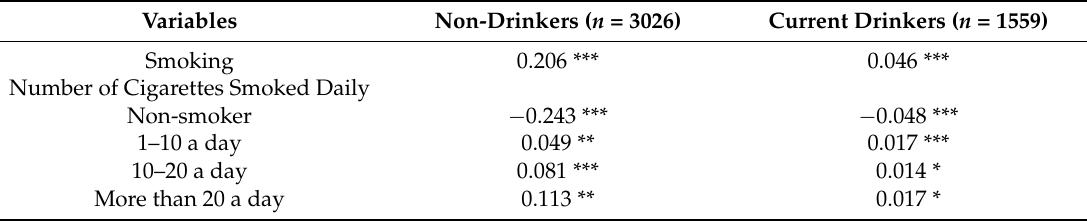
Table 7. Marginal effects of unemployment rate on smoking behavior of drinkers and non-drinkers.